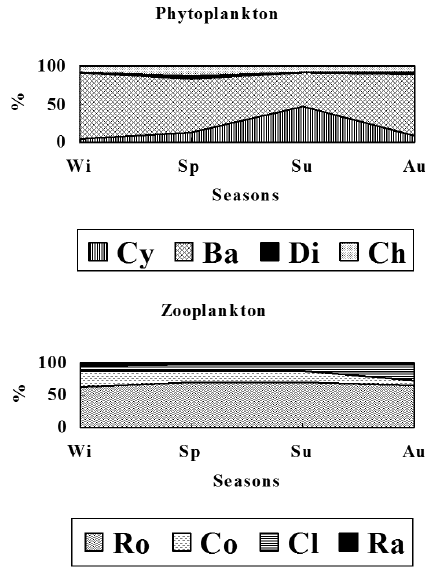
Figure 5. Seasonal fluctuations in percentage contribu- tion of the different plankton groups along the main stream of the Nile in Upper Egypt during 2007.